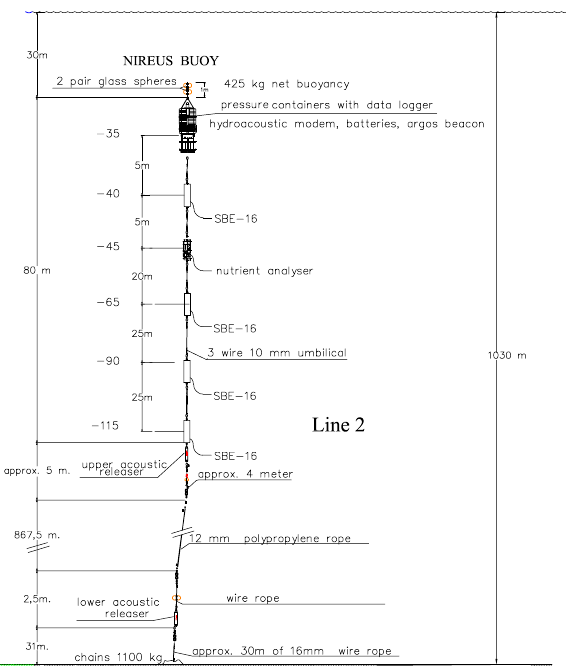
Fig. 2. Details of line 2 of M3A.